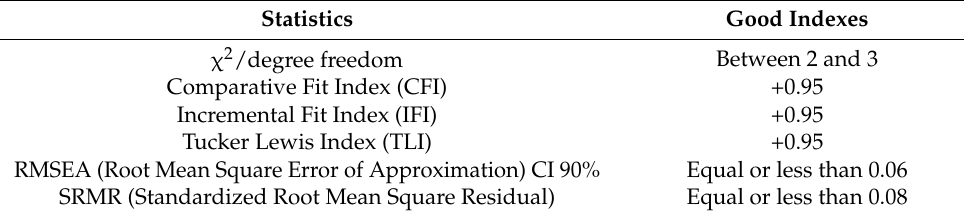
Table 1. Adjustment indexes.